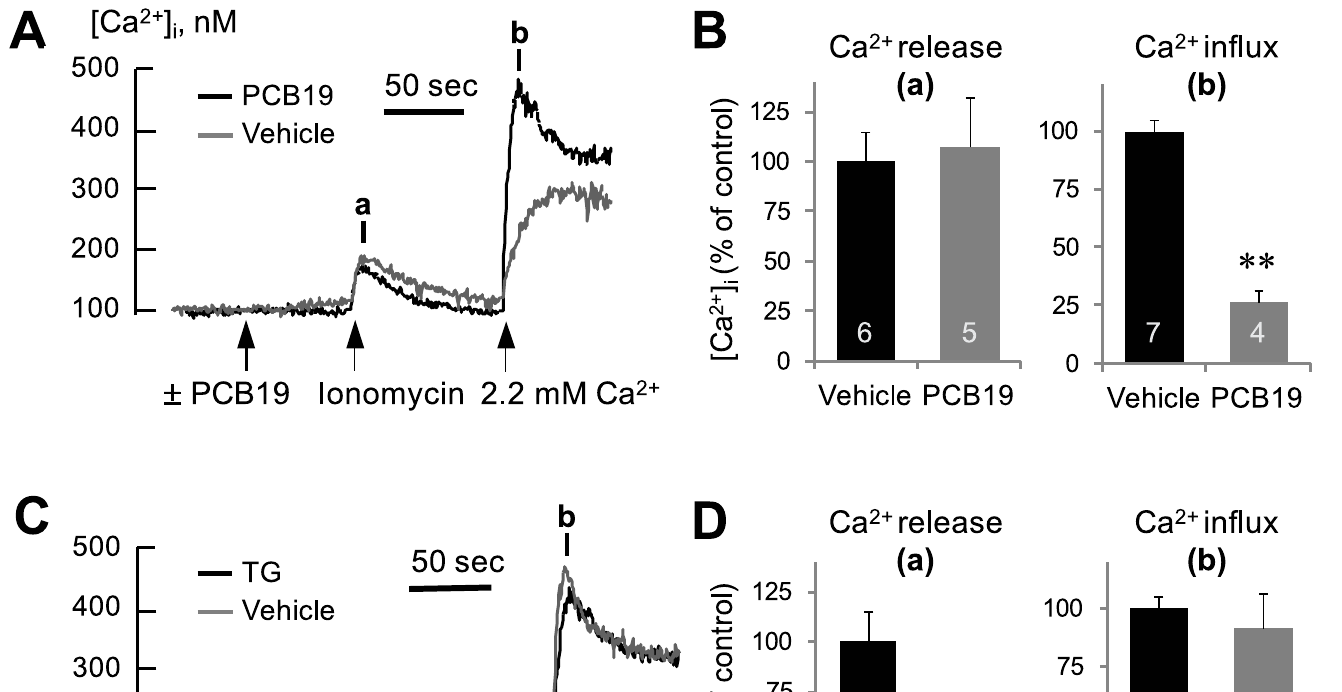
PLOS ONE | DOI:10.1371/journal.pone.0150921 March 10,